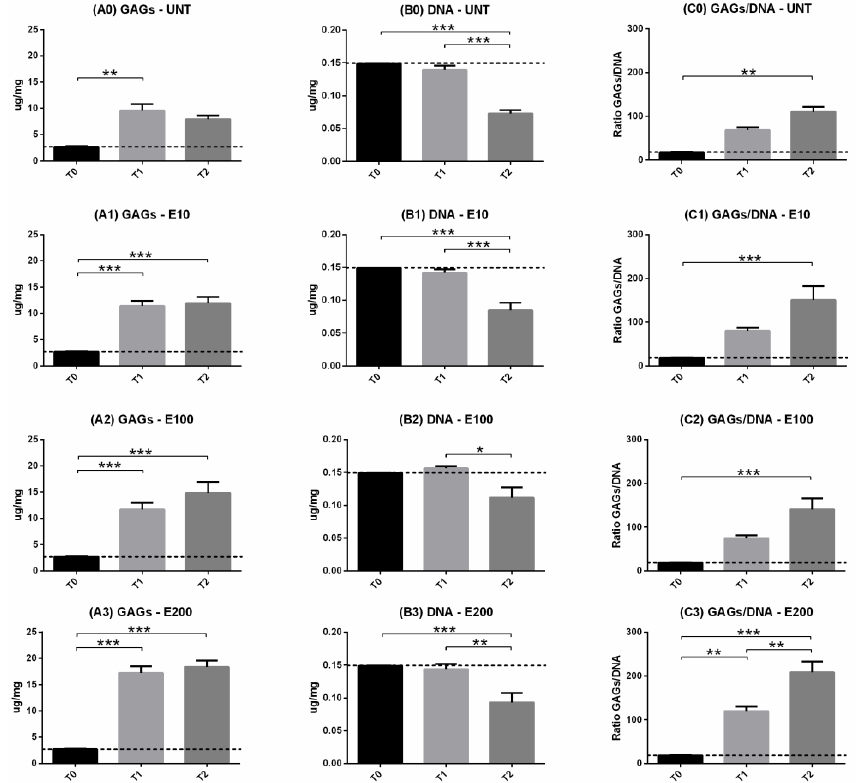
Figure 4. Biochemical analysis: GAGs ( A0 – A3 ) and DNA ( B0 – B3 ) content and their ratio GAG/DNA ( C0 – C3 ). Trends over time (9 days = T1 and 21 days = T2) were illustrated for each treatment. Two- way ANOVA and Tukey’s multiple comparisons test were performed. N = 4; * = p < 0.05; ** = p < 0.01; *** = p < 0.001. Data were expressed as mean ± S.E.M. The dashed black line was the expression level corresponding to T0.